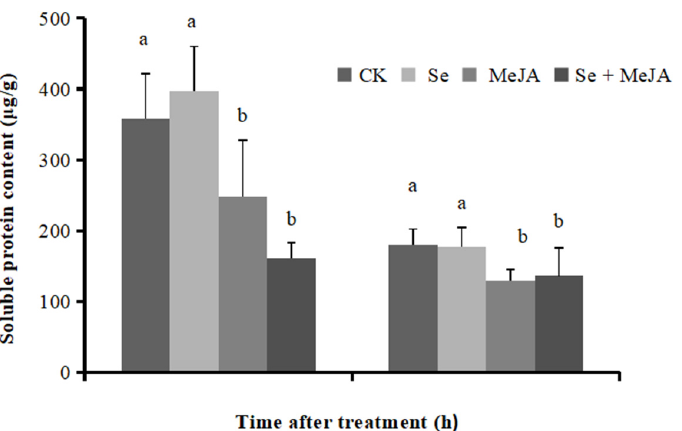
Figure 4. Effect of Se, MeJA and Se + MeJA on soluble protein content for 4 and 8 h (n = 4). CK: Control group; Se: 5.0 mg/L Se; MeJA: 0.4 mM MeJA; Se + MeJA: 5.0 mg/L Se with 0.4 mM MeJA. Vertical bars indicate standard error. Columns followed by different lowercase letters are statistically different according to Duncan’s multiple range test ( p <